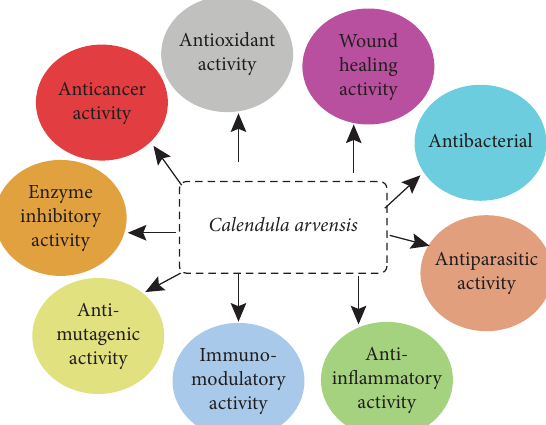
Figure 8: Biological properties of C.